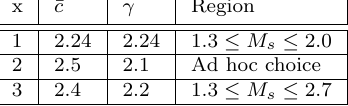
Table 4: Settings for the δ -tuning PID parameters ¯ c , and γ in Alg. 2.1 and Eq. (27). Row 1) s 2 optimized over the robust region and 3) over the entire region. See Figures also 5, 10 and 14. Row 2) is an ad hoc chosen